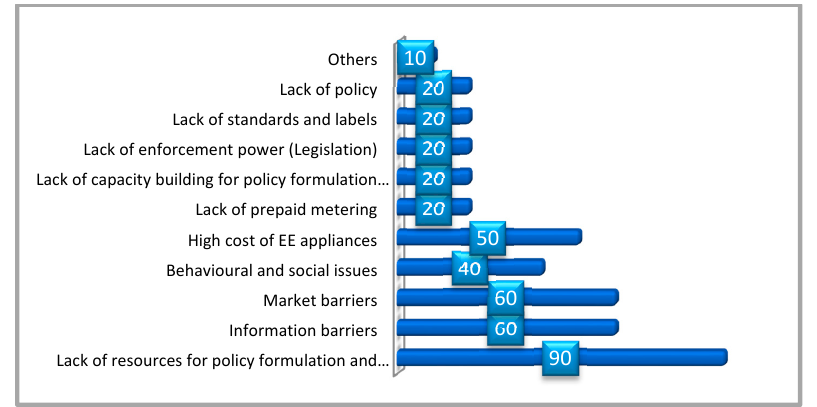
Figure 9. Challenges facing the implementation of energy efficiency policy for major household electrical appliances in Nigeria (in percentage of experts interviewed mentioning certain challenges).